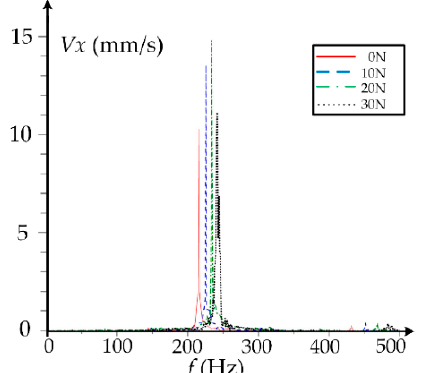
Figure 13. The bearing vibration under different axial loads when L = 1.5.